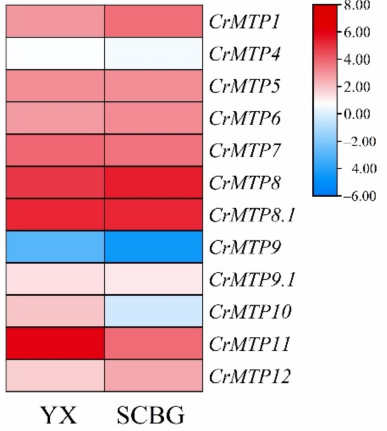
Figure 9. Heatmaps showing the expression differences of the CrMTPs in mature C. rosea leaves planted in South China Botanical Garden (SCBG) and in Yongxing Island (YX). The expression level of each gene is shown with the values of FPKM (log2). Red denotes high expression levels, and blue denotes low expression